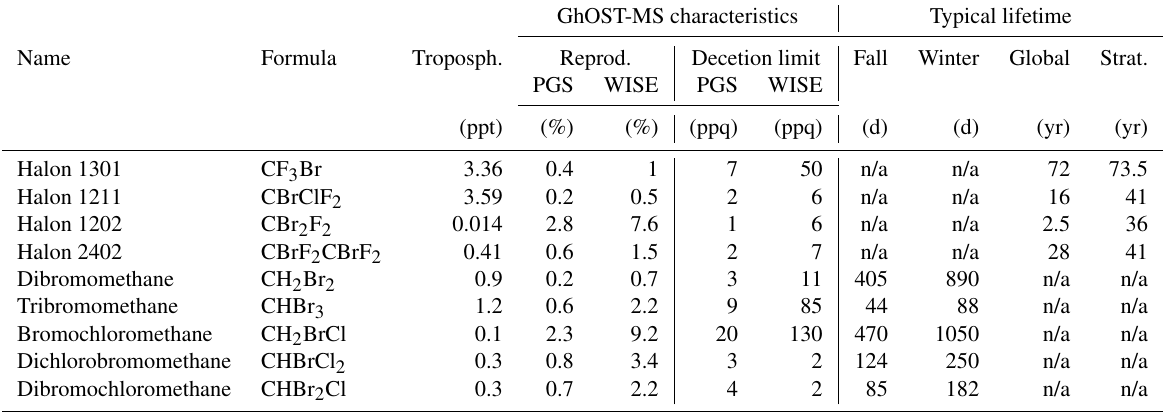
Table 1. Brominated species measured with Gas chromatograph for Observational Studies using Tracers – Mass Spectrometer (GhOST- MS) during three High Altitude and Long Range Research Aircraft campaigns, described in Table 2. Tropospheric mole fractions (parts per trillion, ppt; 10 − 12 ) of the halons are taken from Table 1-1 in Engel and Rigby (2018) and from Table 1-7 for the bromocarbons (marine boundary layer value mixing ratios). Lifetimes of bromocarbons are local lifetimes for upper tropospheric conditions (10km altitude, 25– 60 ◦ N) from Table 1-5 in Carpenter and Reimann (2014) and global/stratospheric lifetimes are from Table A-1 in WMO 2018 (Burkholder, 2018). Local lifetimes are given in days (d), while global and stratospheric lifetimes are given in years (yr). Reproducibilities and detection limits of GhOST have been determined during the WISE and the PGS campaigns. For the TACTS campaign instrument, performance was similar to that reported in Sala et al. (2014).